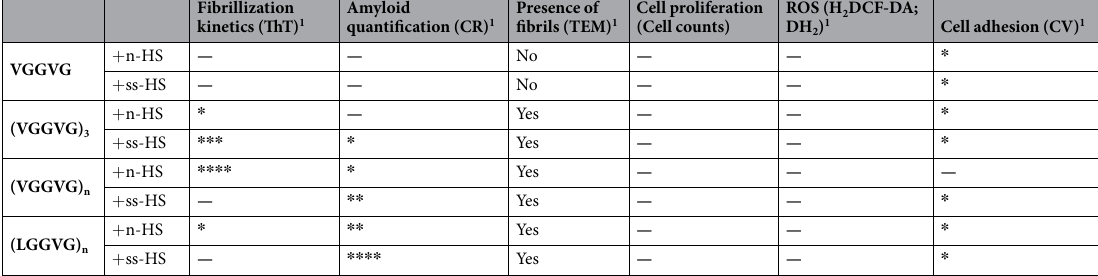
Table 3. Table summarizes the effects of natural (n-HS) and semisynthetic (ss-HS) heparan sulfates added to elastin-like peptides in comparison with elastin-like peptides (ELPs) alone. * p < 0,05; ** p < 0,01; *** p < 0,001; **** p < 0,0001 of ELP + HS vs same ELP alone; “ —” indicates no effect. 1 ThT (Thioflavin T); CR (Congo